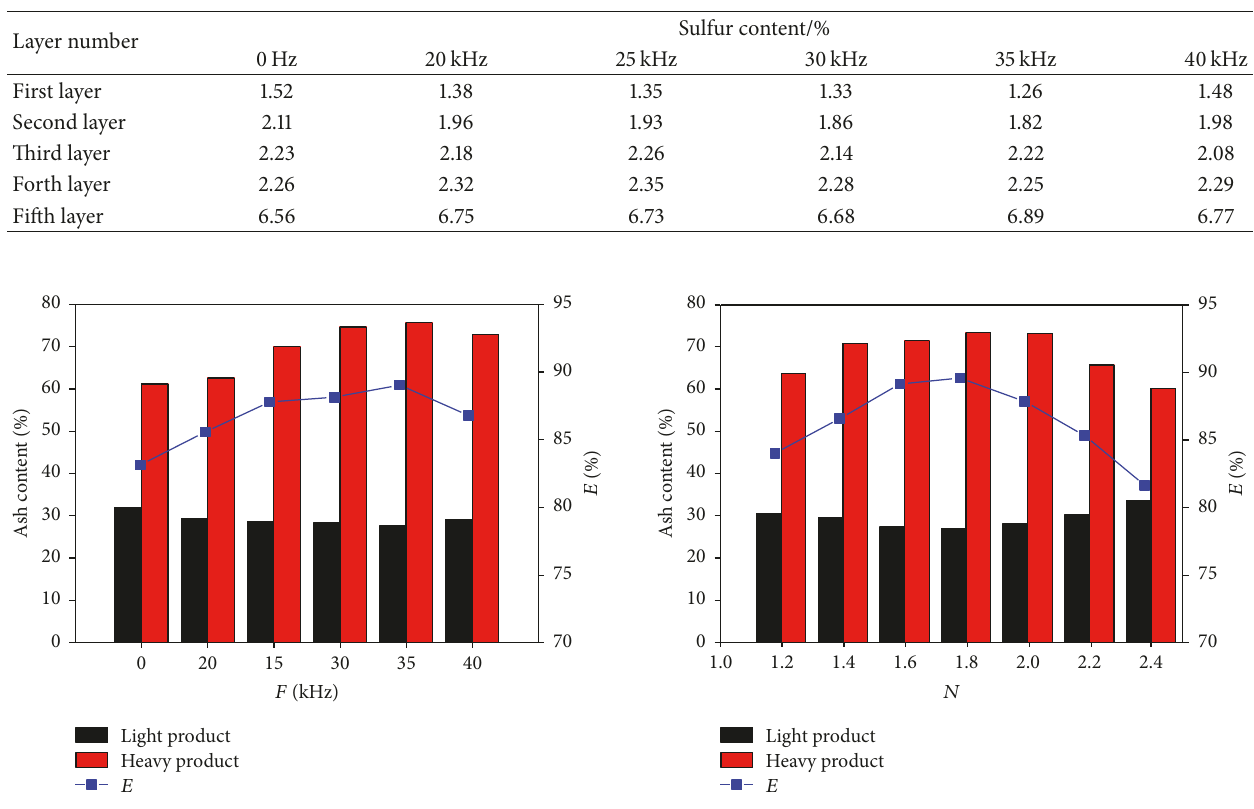
Table 1: Sulfur content of each layer of product.